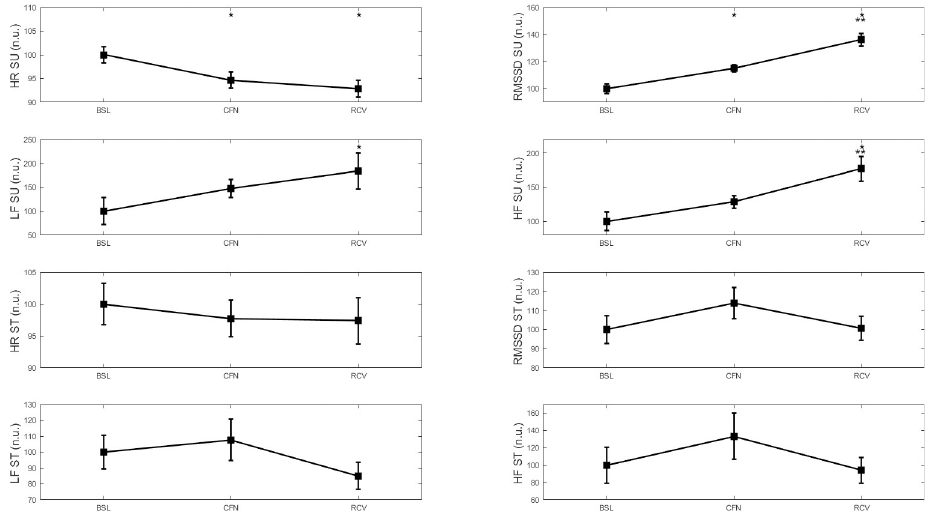
Fig 2. HR, RMSSD, LF and HF before (BSL), during (CFN) and after (RCV) the strict lockdown period in France in 19 participants who improved their well-being over the CFN period. SU: supine position, ST: standing position. � p < 0.05 �� p < 0.01 for difference with BSL. # p < 0.05 for difference with